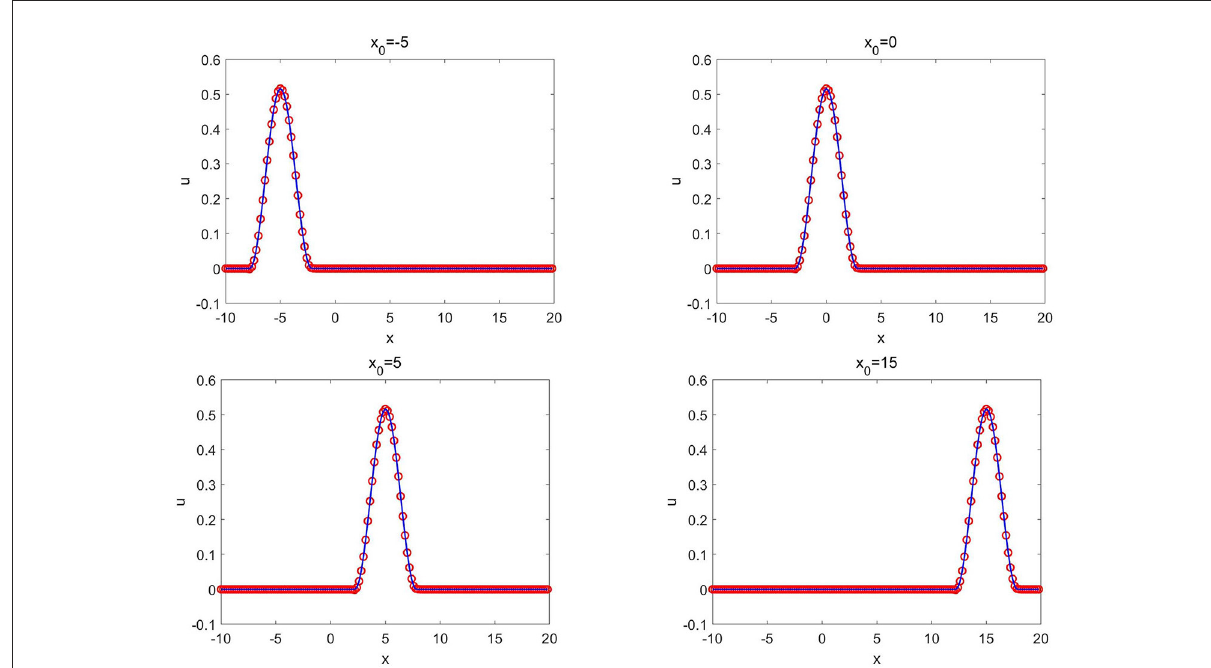
FIGURE14 Generalized fifth order KdV equation of Example 3.8: the CANN solution (red circles) and the exact solution (solid blue lines) at T different values of x 0 where λ